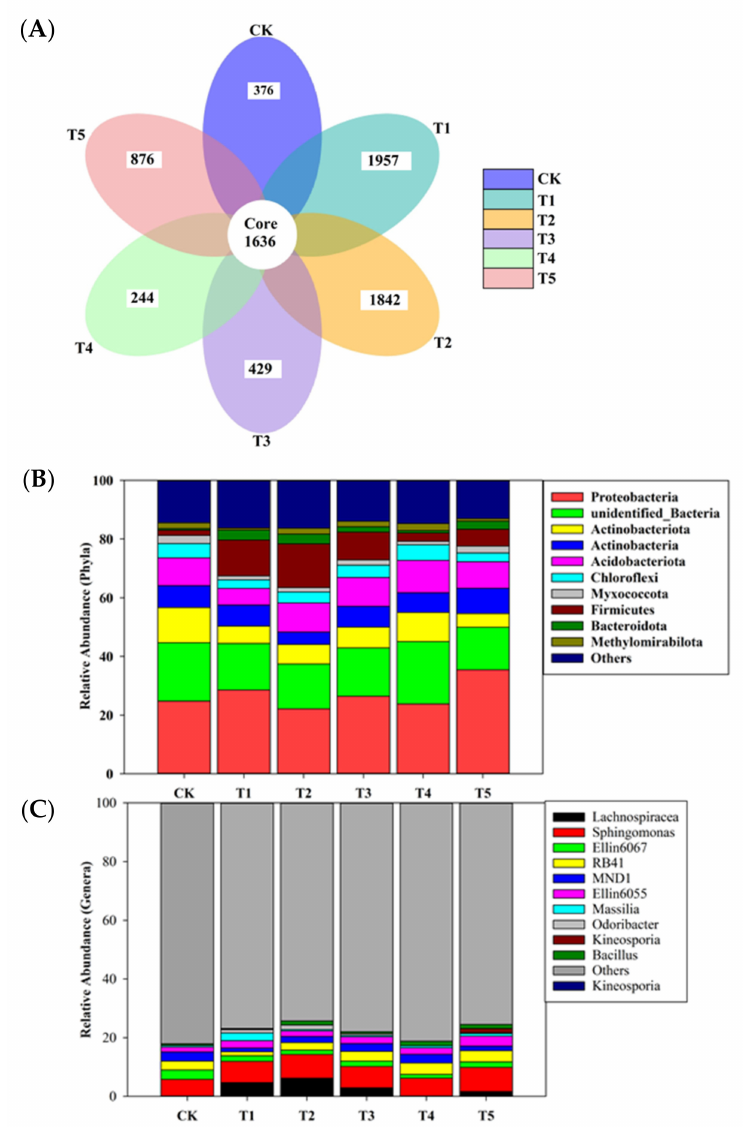
Figure 2. ( A ) Venn diagram illustrating number of unique and shared OTUs; ( B ) relative abundance of major bacterial phyla in each treatment; ( C ) relative abundance of major bacterial genera in each